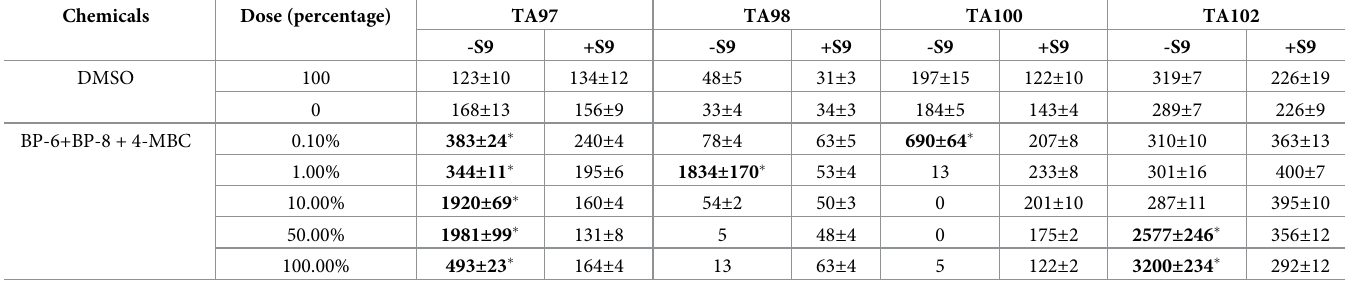
Table 5. Reverse mutation colonies of four S . typhimurium strains exposed to mixtures of BP-6, BP-8, and 4-MBC with and without S9. Chemicals